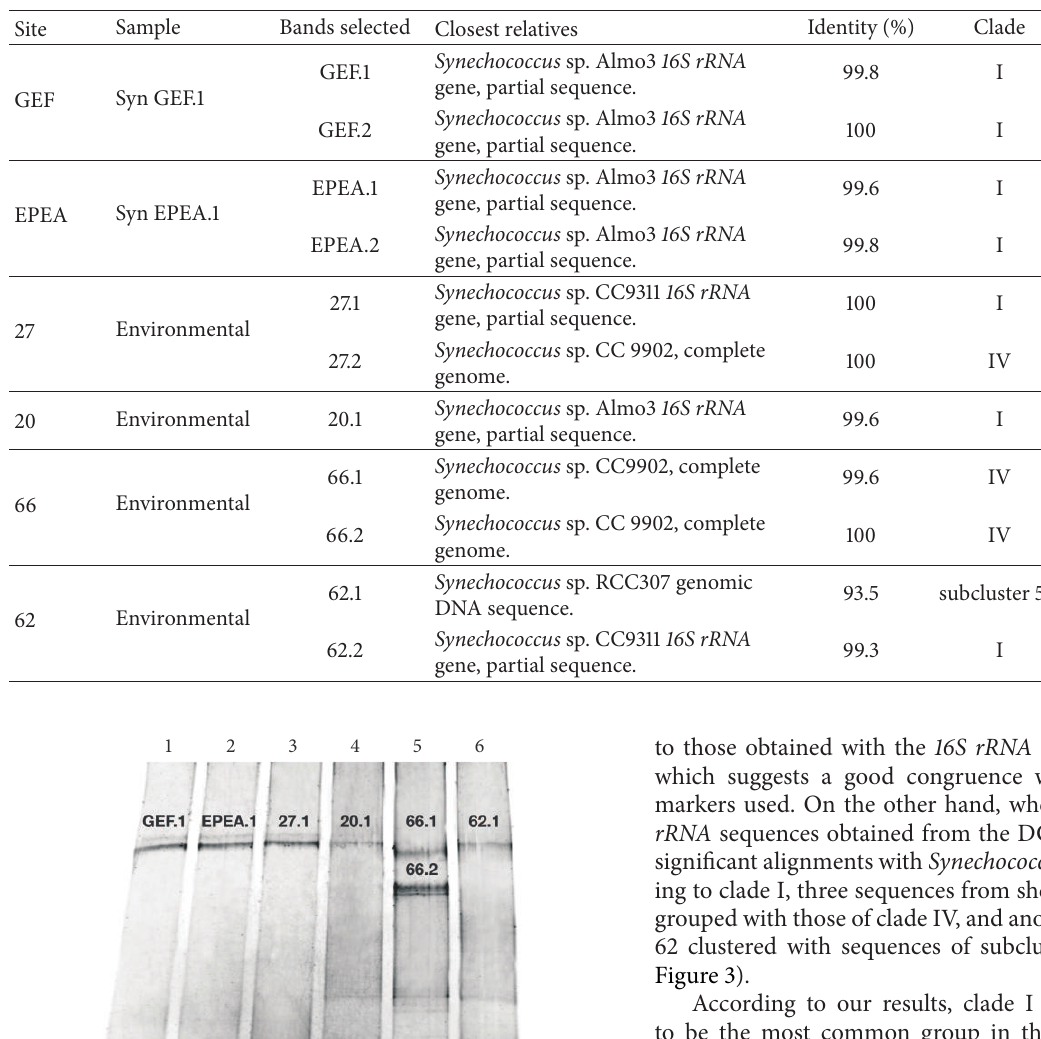
Table 2: Analysis of 16S rRNA sequences from the DGGE excised bands (Figure 2) of environmental samples from the Argentine Sea. The isolated strains Syn-EPEA.1 and Syn-GEF.1 were used as reference. 𝐸 values of all sequences were 0.0.